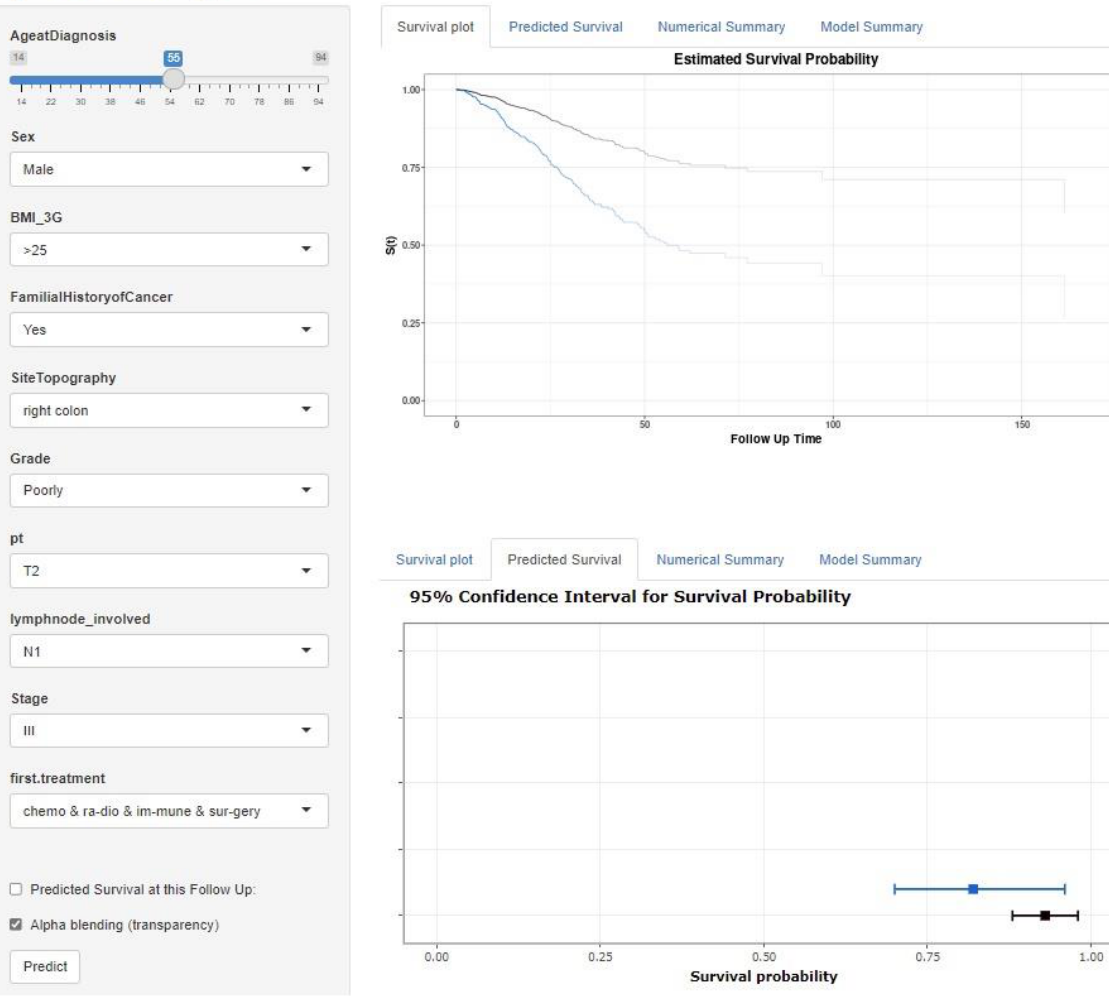
Figure 2. Dynamic nomogram for the Cox proportional hazards model, fitted to the Colorectal cancer patient’s data, on web page (Dynamic Nomogram (shinyapps.io), https://nbshiny.shinyapps.io/DynNomColorectal/). The Kaplan-Meier plots display survival curve correspond to 55 years old male, BMI > 25, have a family history, cancer in the right colon, T2 T-stage, N1 N-stage, stage III, receive all treatments, and well-differentiated grade (in black color) vs. a patient with the same characteristics and poorly differentiated grade (in blue color), shown in the left side of the picture (upper). The patients’ corresponding predicted survival probability and 95% confidence intervals at a specific time is given in the ‘Predicted survival’ tab, shown on the left side of the picture (lower). The predicted value with corresponding confidence interval and the formatted model output summary are presented in the ‘Numerical Summary’ and ‘Model Summary’ tabs, respectively.